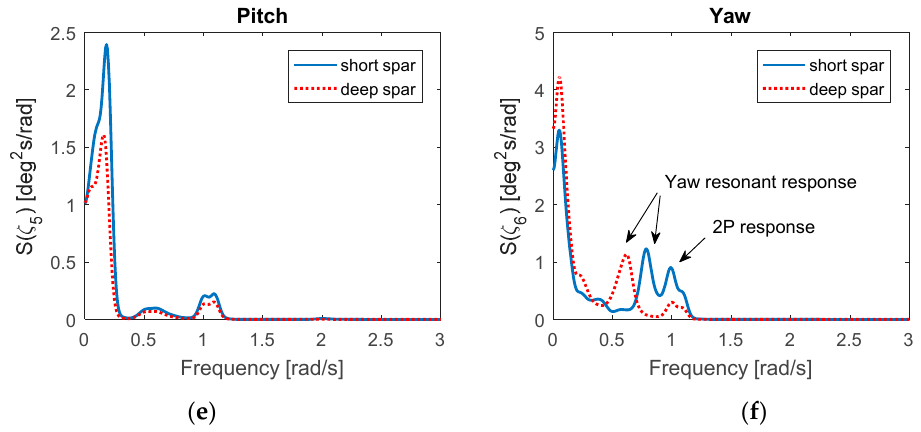
Figure 10. Comparison of power spectra in six degrees of freedom for the short and deep spar VAWT under LC3 with U w = 14 m/s, H s = 3.62 m, T p = 10.29 s: ( a ) Surge; ( b ) Sway; ( c ) Heave; ( d ) Roll; ( e ) Pitch; ( f ) Yaw.